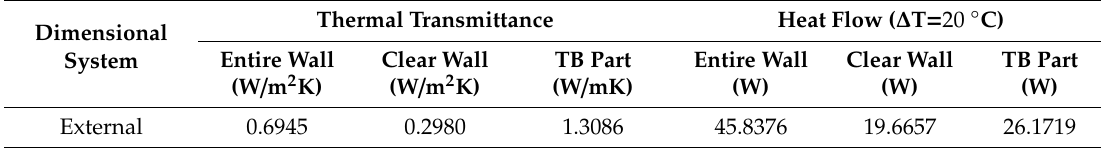
Table 2. Steady-state analysis results (grid size: 20 mm).